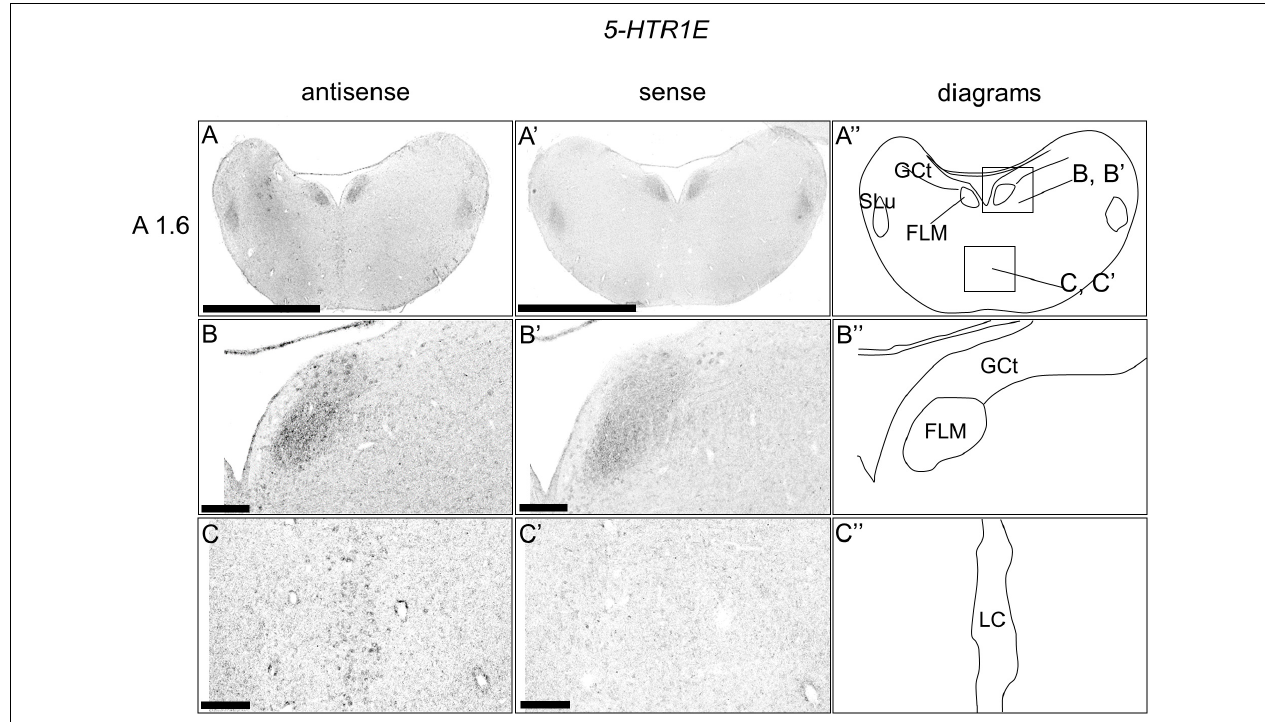
FIGURE 6 | In situ hybridization of 5-HTR1E in the P1 chick brainstems. Digoxigenin-labeled RNA antisense (A–C) and sense (A’–C’) 5-HTR1E probes were used for in situ hybridization in coronal sections of P1 chick brains. To evaluate the expression patterns of 5-HTR1E , sections of four chicks were analyzed, and the representative levels of sections (A 1.6) are shown. (A”–C”) Diagrams of coronal sections shown in the rightmost panels. The levels of the sections (A 1.6) is in accordance with those mentioned in Kuenzel and Masson’s chick atlas (Kuenzel and Masson, 1988). (B–C,B’–C’) Magnified views of brain areas shown in the boxes in panel (A”) . FLM, fasciculus longitudinalis medialis; GCt, griseum centrale; MR, median raphe; SLu, nucleus semilunaris; P1, post-hatch day 1. Scale bars = 2.5 mm (A,A’) and 250 µ m (B–C,B’–C’)